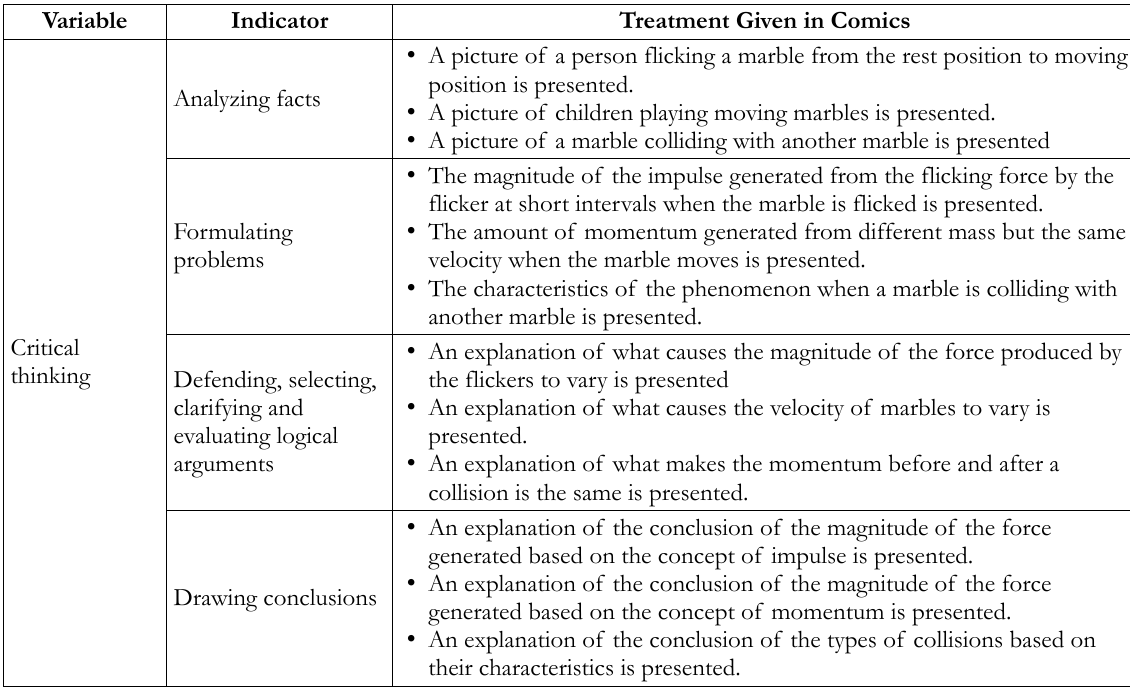
Table 1. Analysis of physics aspects of indigenous knowledge of marbles game